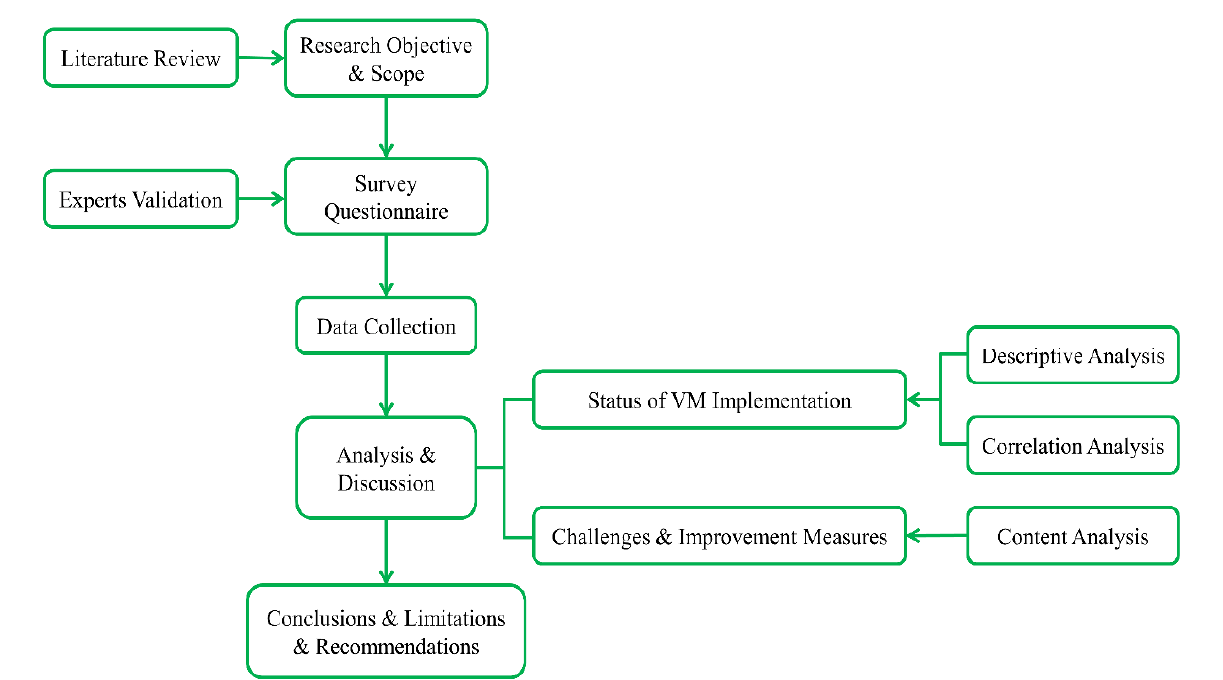
Figure 1. Methodological framework of the study.